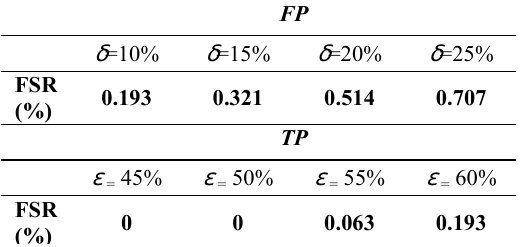
Table 4. False positive rates (FPS) of TP-Detector and FP-Detector on D_Ano . The size of their sliding windows is 11. In FP-Detector , min- supports are respectively set into 10%, 15%, 20%, 25%. In FP-Detector , matching parameter w = 1/